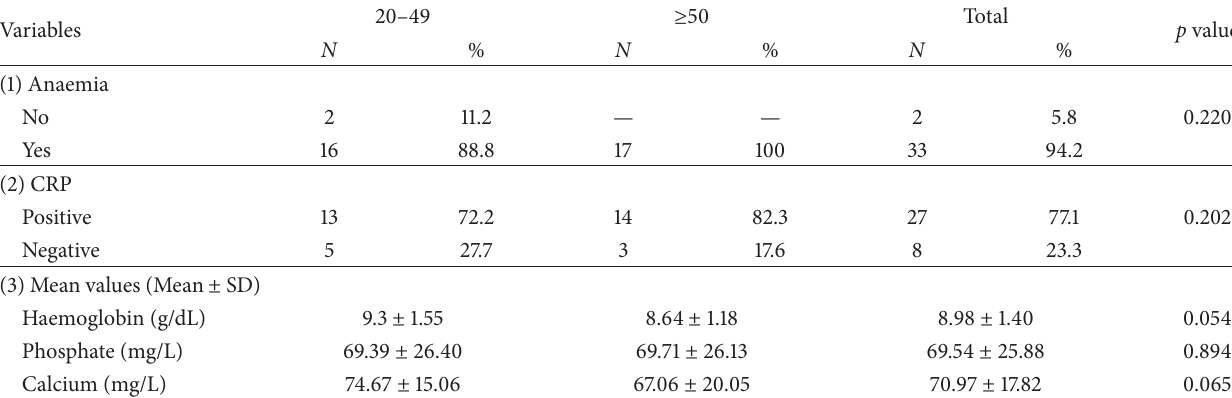
Table 3: Distribution of specific cardiovascular disease risk factors among haemodialysed patients by